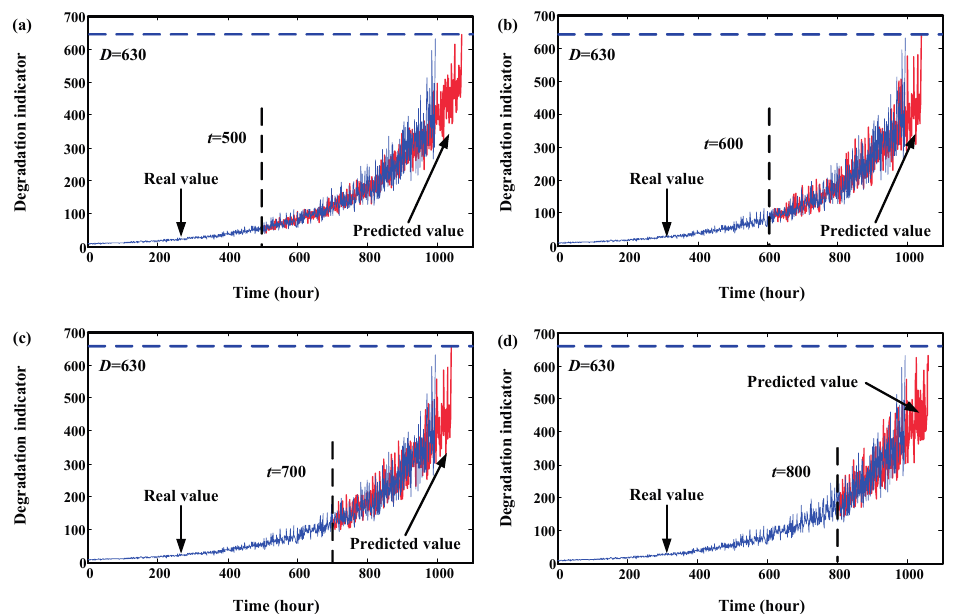
Figure 12. Trend prediction results of simulated data of Component 2. ( a ) prediction results at start time 500 h; ( b ) prediction results at start time 600 h; ( c ) prediction results at start time 700 h; ( d ) prediction results at start time 800 h.